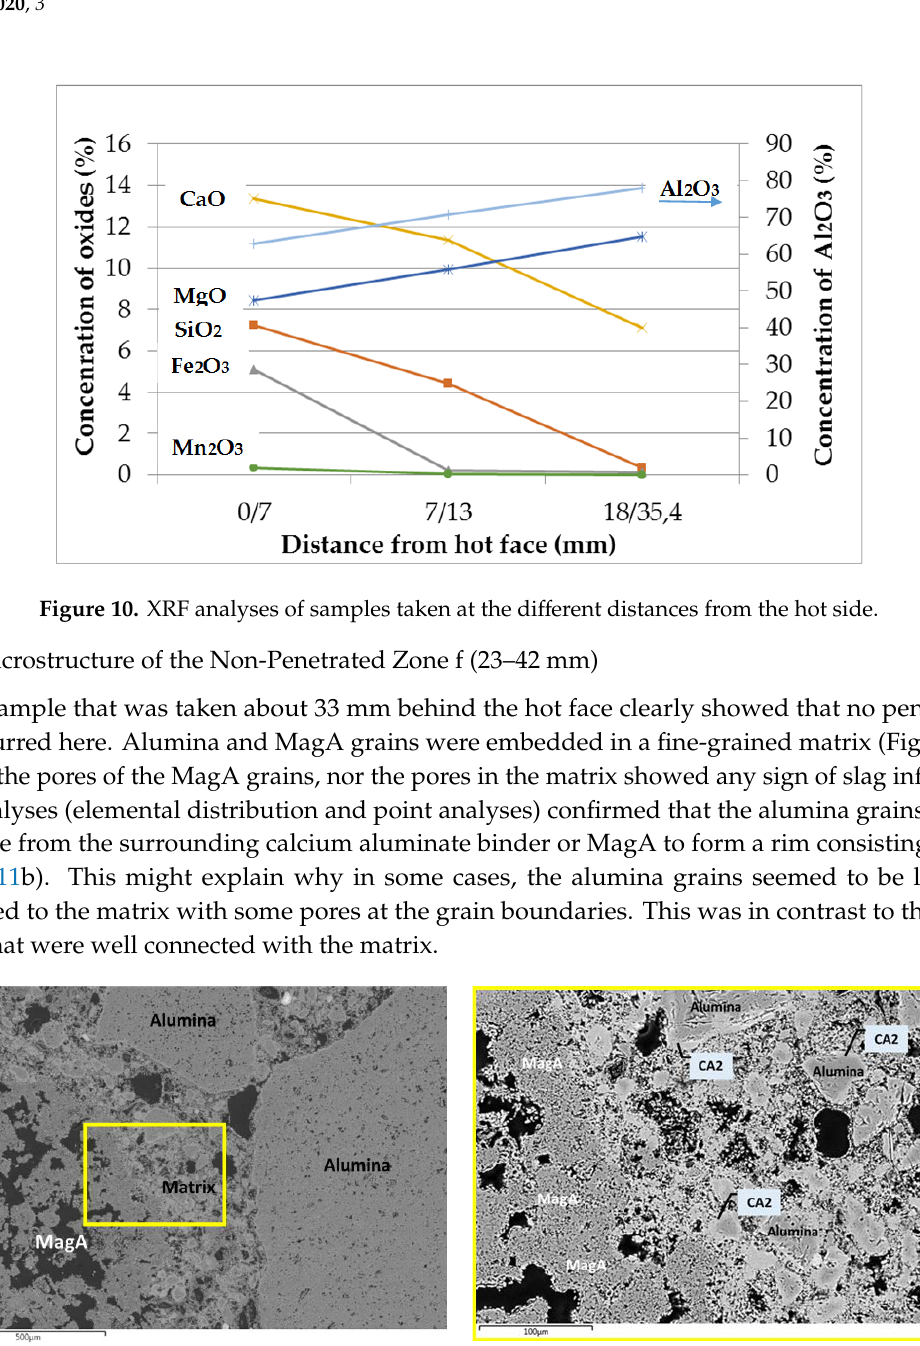
Figure 12. Element distribution in the non-infiltrated zone of the MagA-gun. About 20–42 mm into the material, still some CA was present, either originated from the MagA aggregate or the calcium aluminate binder. This showed that the temperature gradient in the gunning mix was quite high as the temperature was not high enough here to transfer all CA by sintering reaction with alumina into CA 2 or CA 6 . Measurements of thermal conductivity will be conducted to quantify the temperature gradient that can be expected in the MagA-containing materials. The macro crack, which occurred about 20–23 mm behind the hot face, probably opened during cooling of the ladle to ambient temperature, as it was free of any penetration. 3.3.3. Microstructure at the Interface with Substrate, Zone g (42–45 mm) At the back side of the MagA-gun sample, the contact zone towards the substrate, a thin layer or flakes of iron oxide, present as FeO and Fe 3 O 4 , were observed. These were most likely the remains